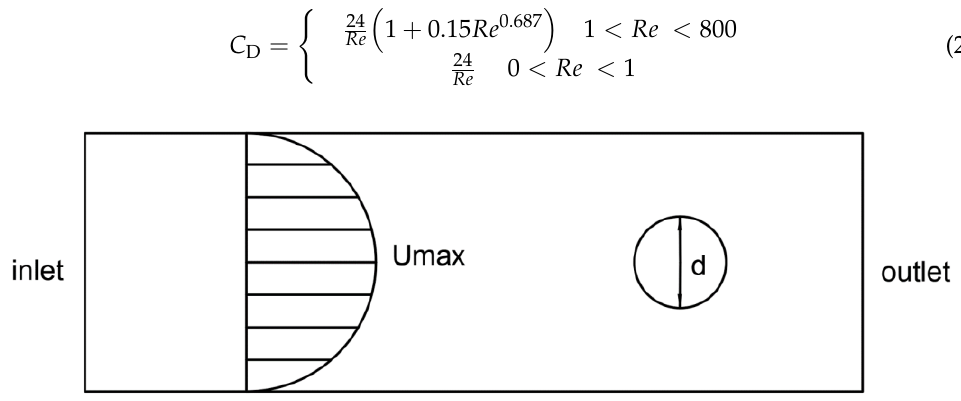
Figure 10. Distribution velocity of D2Q9.